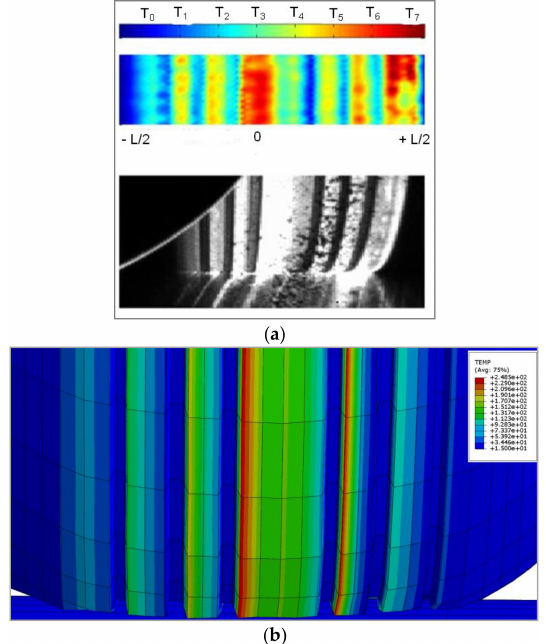
Figure 21. Thermal evolution of the tire tread, numerical simulation, for a tire loading with 200 kN, rolling velocity up to 190 km/h, skidding angle of 6 ◦ , ( a ) experimental data, ( b ) numerical